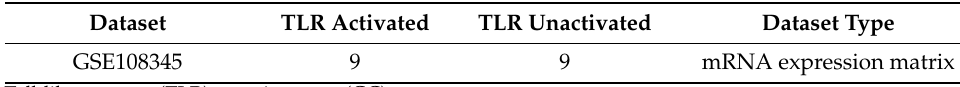
Table 2. Gene microarray data related to activation of TLRs in GC. Dataset TLR